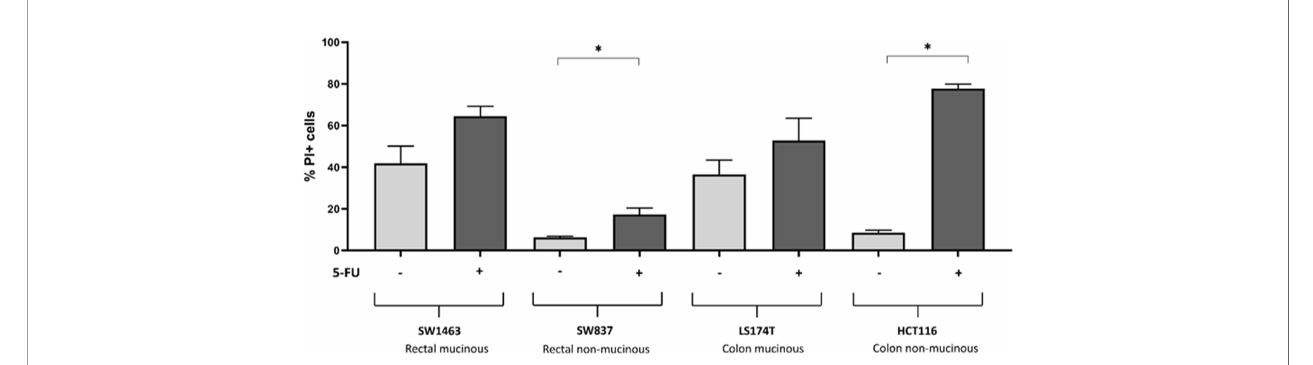
FIGURE 5 | Cell death assay to determine cell death rate by measurement of PI positive cells. Cells treated with DMSO control versus 25 m M 5-FU. * indicates p<0.05 for comparison between control and treated cells within